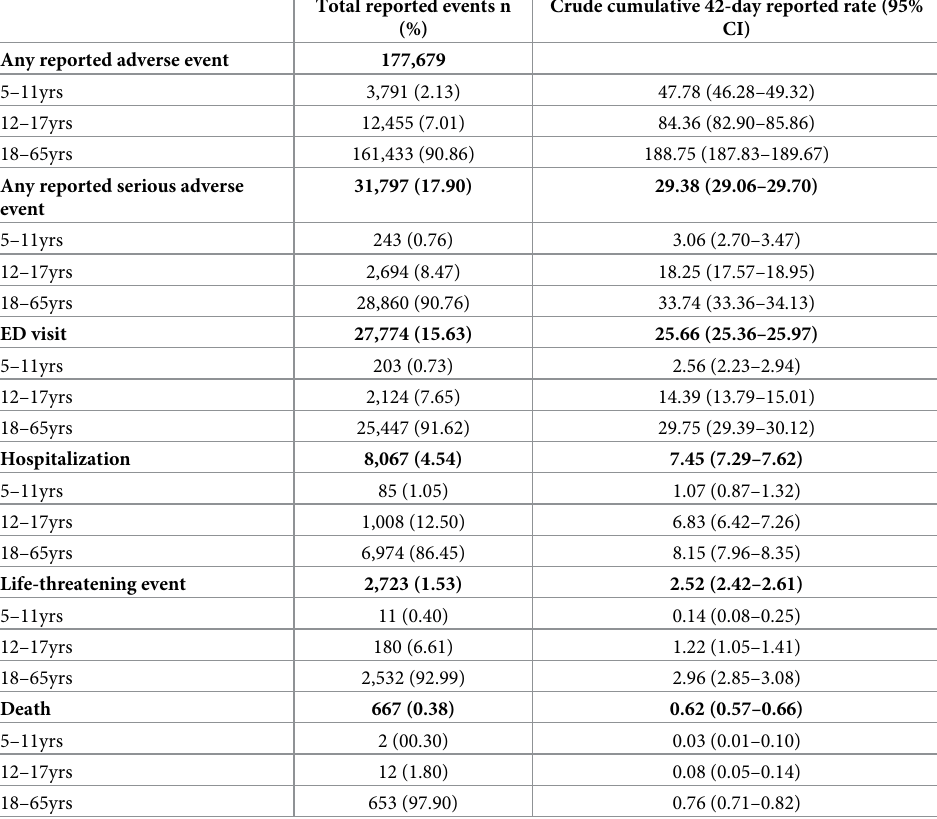
Table 2. Crude cumulative reported rates for serious adverse events associated with BNT-162b2 amongst over 5-year-old vaccinated recipients. Total reported events n Crude cumulative 42-day reported rate (95% (%)